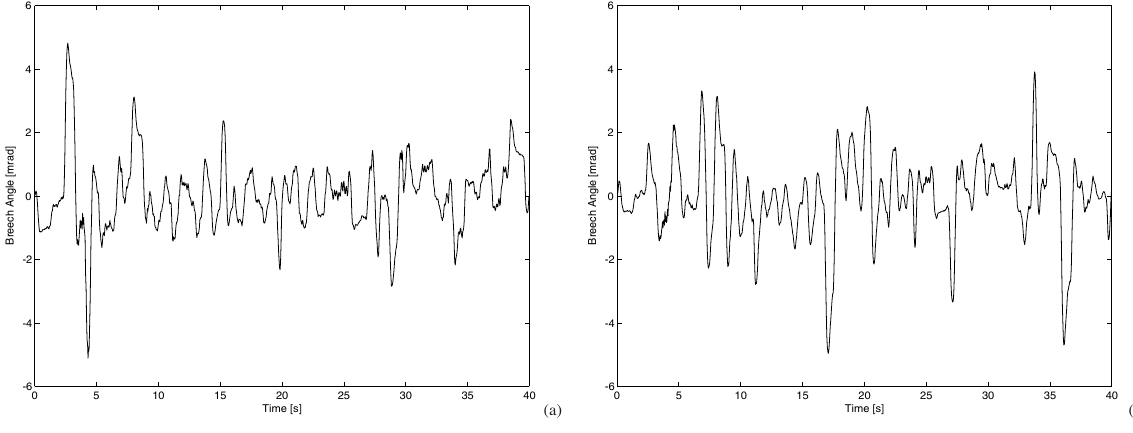
Fig. 7. Plot of the breech angle, with the balanced (a) and OOB (b)